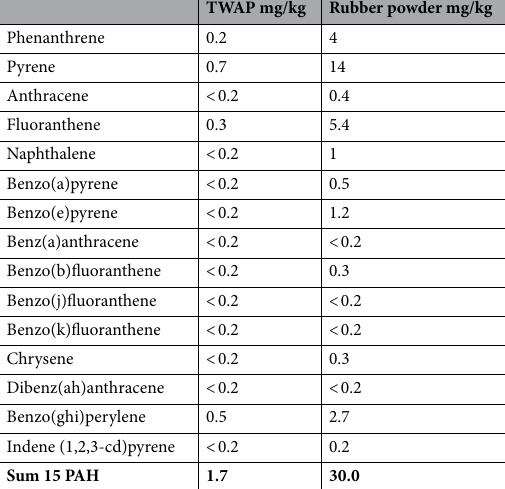
Table 4. PAH amounts of TWAP and rubber powder measured according to AfPS GS 2019:01